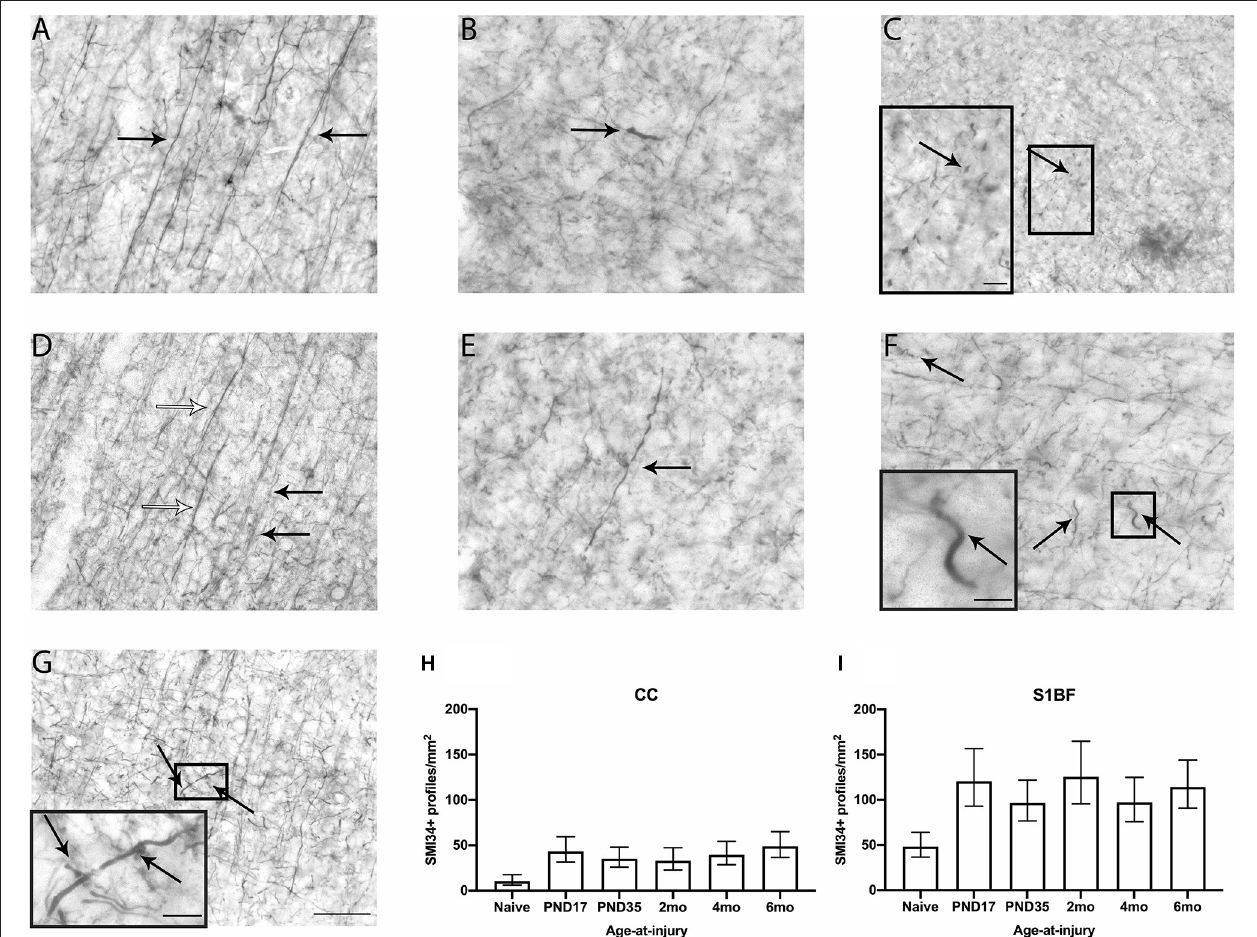
FIGURE 2 | SMI34 axonal profiles were quantified in the CC and S1BF. Indicative images of healthy axons (A) and axonal pathology visualized by SMI34 immunohistochemistry were taken in the primary sensory barrel field (S1BF) of rats brain-injured at 6-months of age. Analysis quantified bulbs (B) , blebbing (C) , thickened axons (white arrows; D ) or undulated axons (black arrows; D ), thickened and undulated axons (E) , corkscrews (F) , and rings (G) indicated by the arrows (scale bar = 50 µ m, inset = 10 µ m). Counts of axonal pathology are expressed as the number of SMI34 + profiles/mm 2 (mean ± 95%CI) in the corpus callosum (CC) and S1BF. There were significantly more SMI34-positive (SMI34 + ) profiles observed post-injury, regardless of age-at-injury, compared to naïves in both the CC (H) and the S1BF (I) .